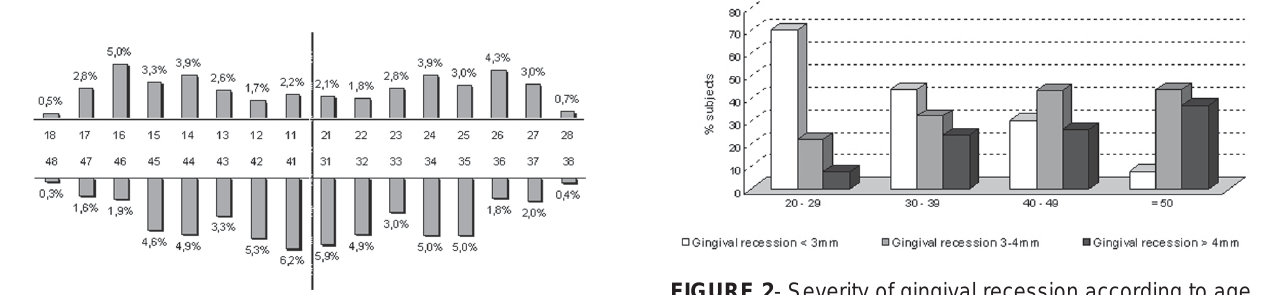
FIGURE 1 - Intraoral distribution of gingival recession